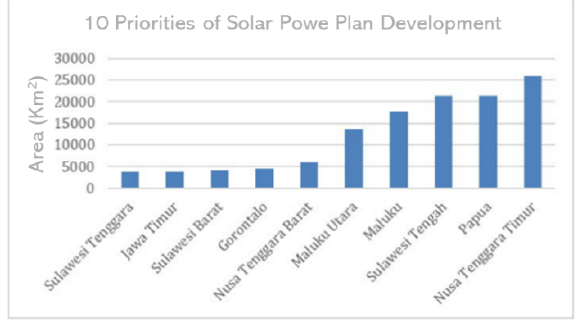
Figure 4 . Multi-Scenario Model